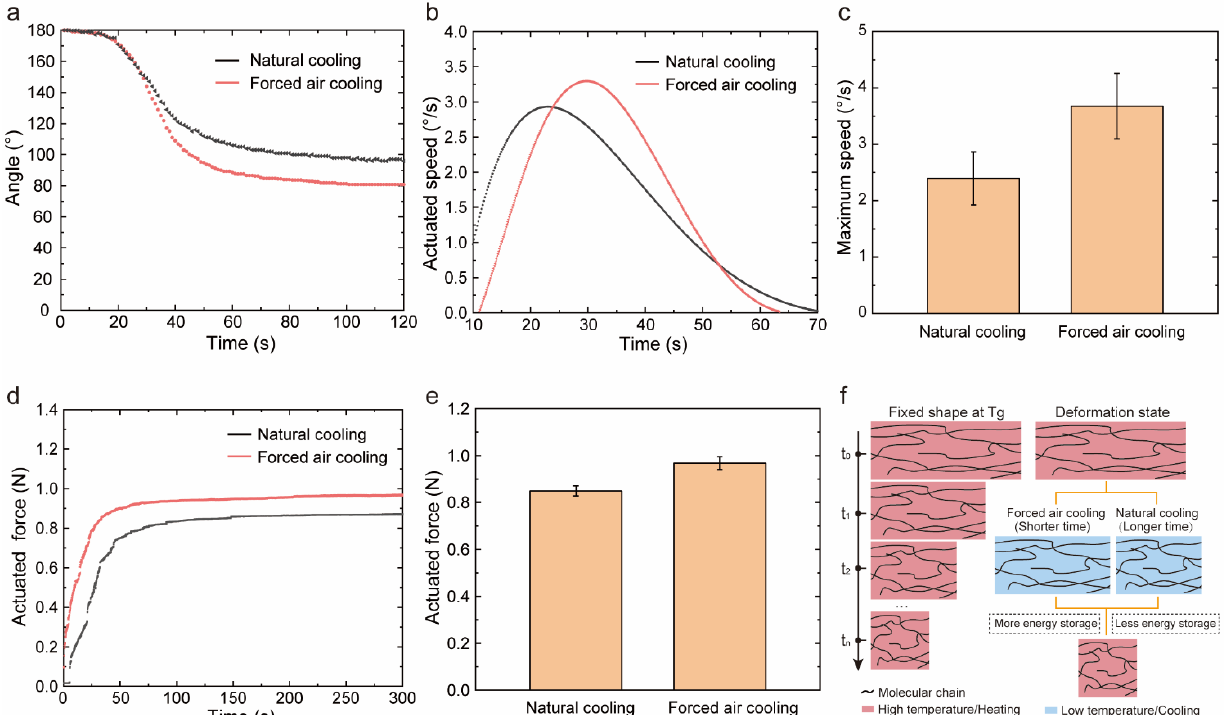
Figure 4. The effect of cooling speeds on shape memory properties and actuation performances. ( a ) The variation in angle for different cooling speeds. ( b ) The angular speed for different cooling speeds. ( c ) The maximum speed for different cooling speeds in the recovery process. ( d ) The recovery force for different cooling speeds. ( e ) The maximum recovery force for different cooling speeds. ( f ) The schematic diagram of effect for different cooling speeds.